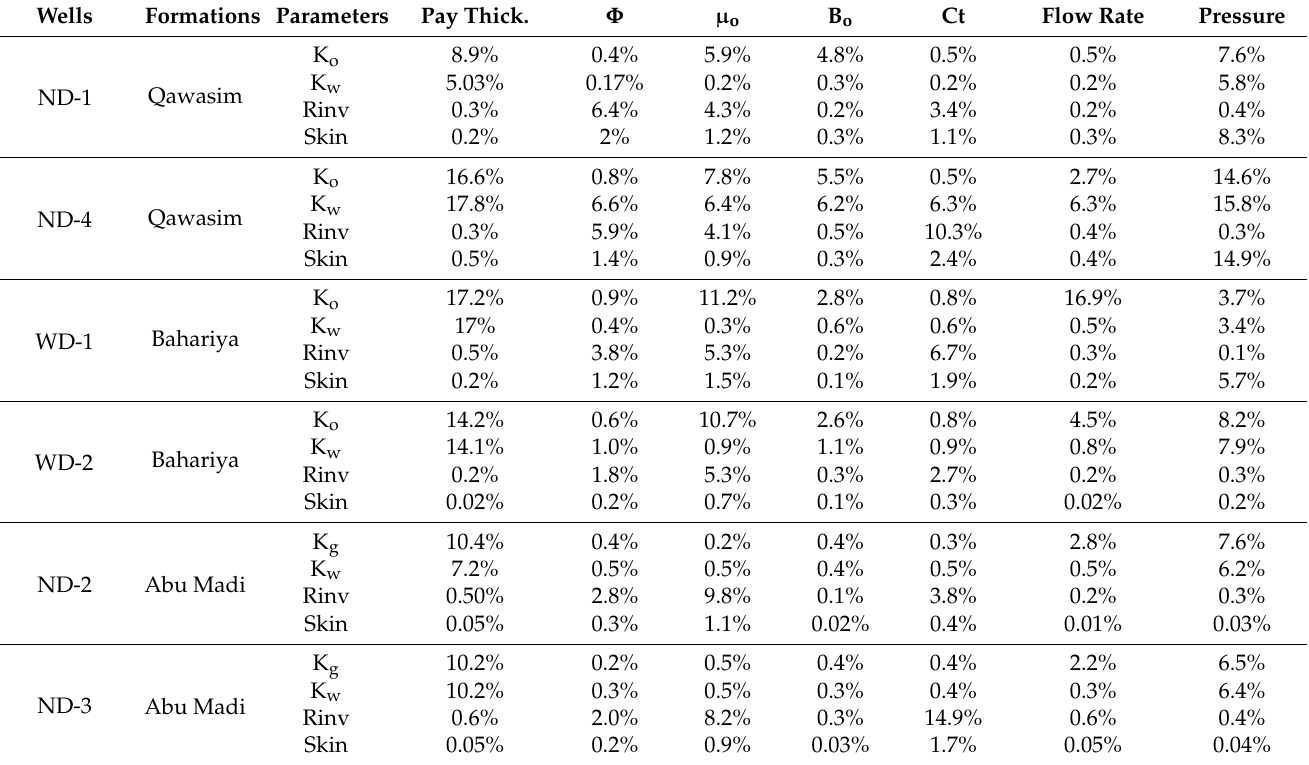
Table 7. The error analysis results for all wells under full probability region (P0 to